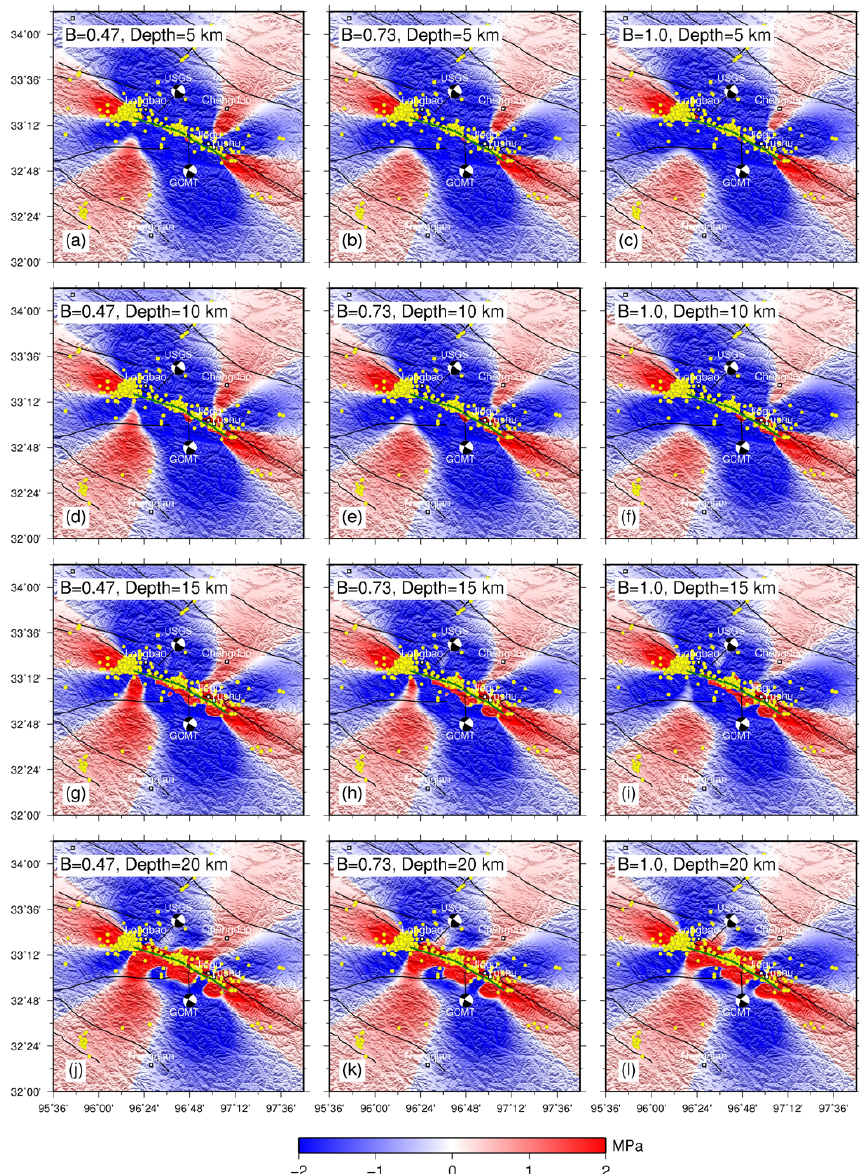
Fig. 8. Static Coulomb stress changes caused by the 2010 Yushu mainshock. The Skempton’s coefficient varied from 0.47 to 1.0 and depth ranged between 0 and 20km. The yellow circles are aftershocks ( M > 2.0) from ISC (http://www.isc.ac.uk) till 16 December